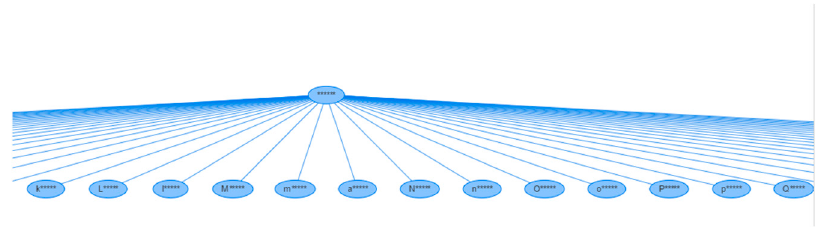
Figure 15. Hierarchy userdescription.